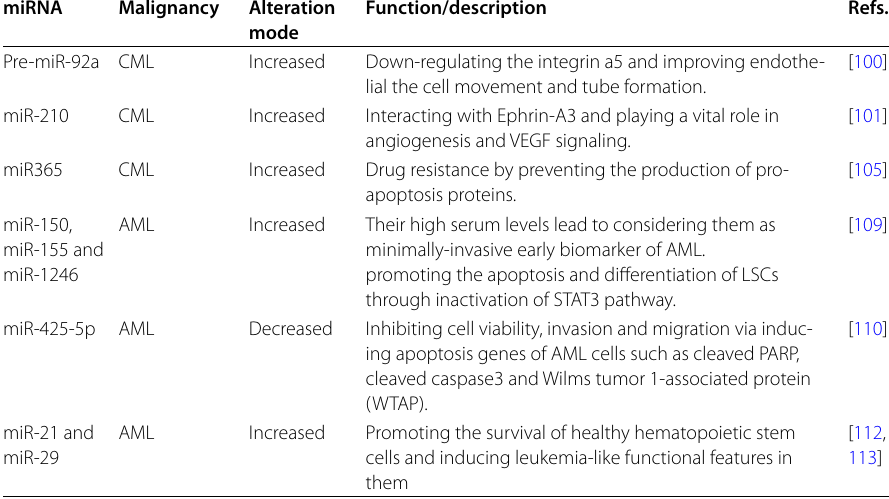
Table 2 Exosomal miRNAs associating in CML and